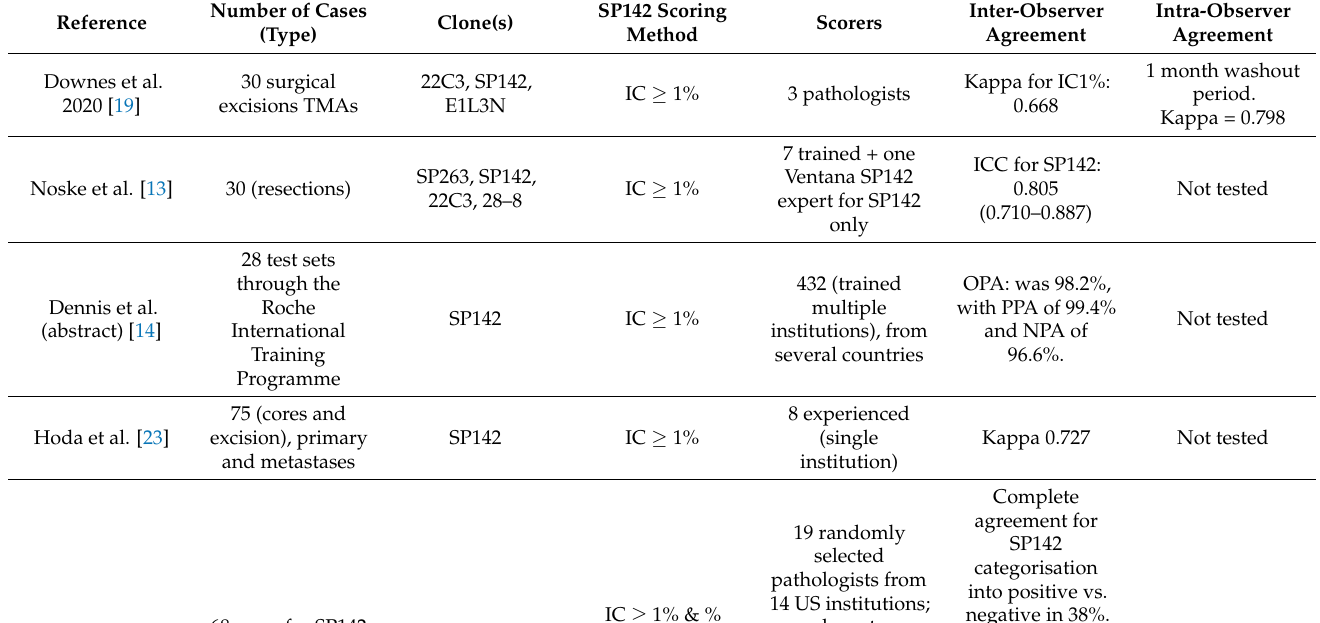
Table 9. Summary of studies evaluating the SP142 PD-L1 concordance of